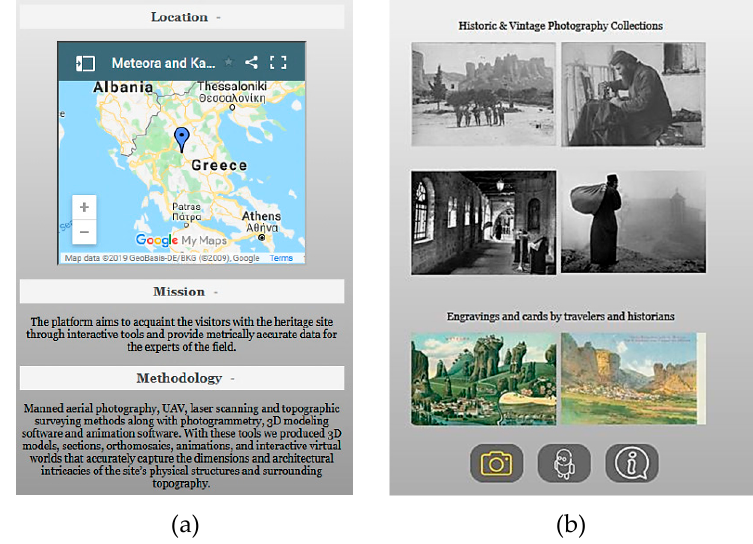
Figure 7. Homepage of the 3D platform with details from the side column: ( a ) tabs with map location and brief description of the purpose and methodology ( b ) various image galleries.